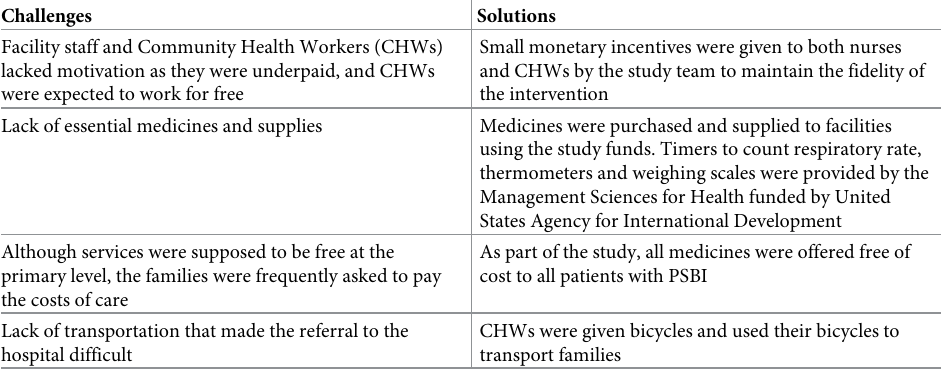
Table 5. Challenges and solutions during